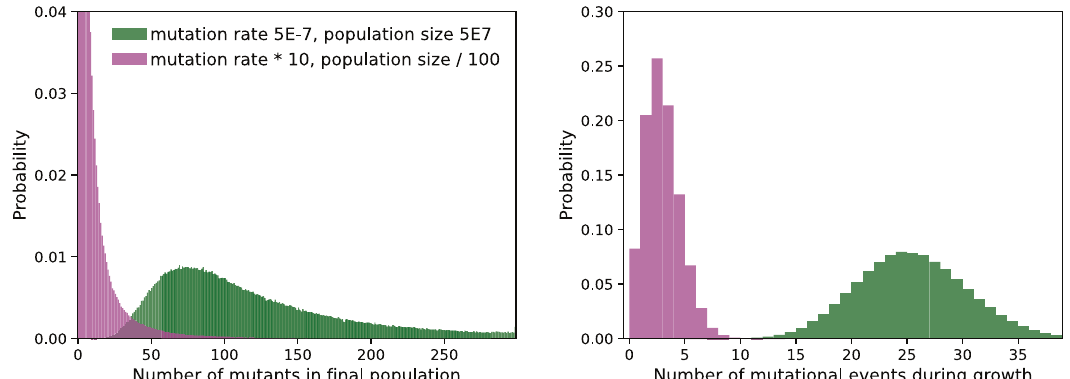
Fig. 1 Change in genetic diversity due to a hypothetical treatment that increases mutation rate (x10) but decreases population size (/100). The left panel shows the distribution of the number of mutants in the fi nal population for 1000 simulations. The right panel shows the distribution of the number of mutational events in the same simulations. The number of mutational events gives a more precise estimation of genetic diversity, because a single mutational event can give several times the same mutant in the fi nal population. The number of (non- unique) mutants, however, can be directly measured